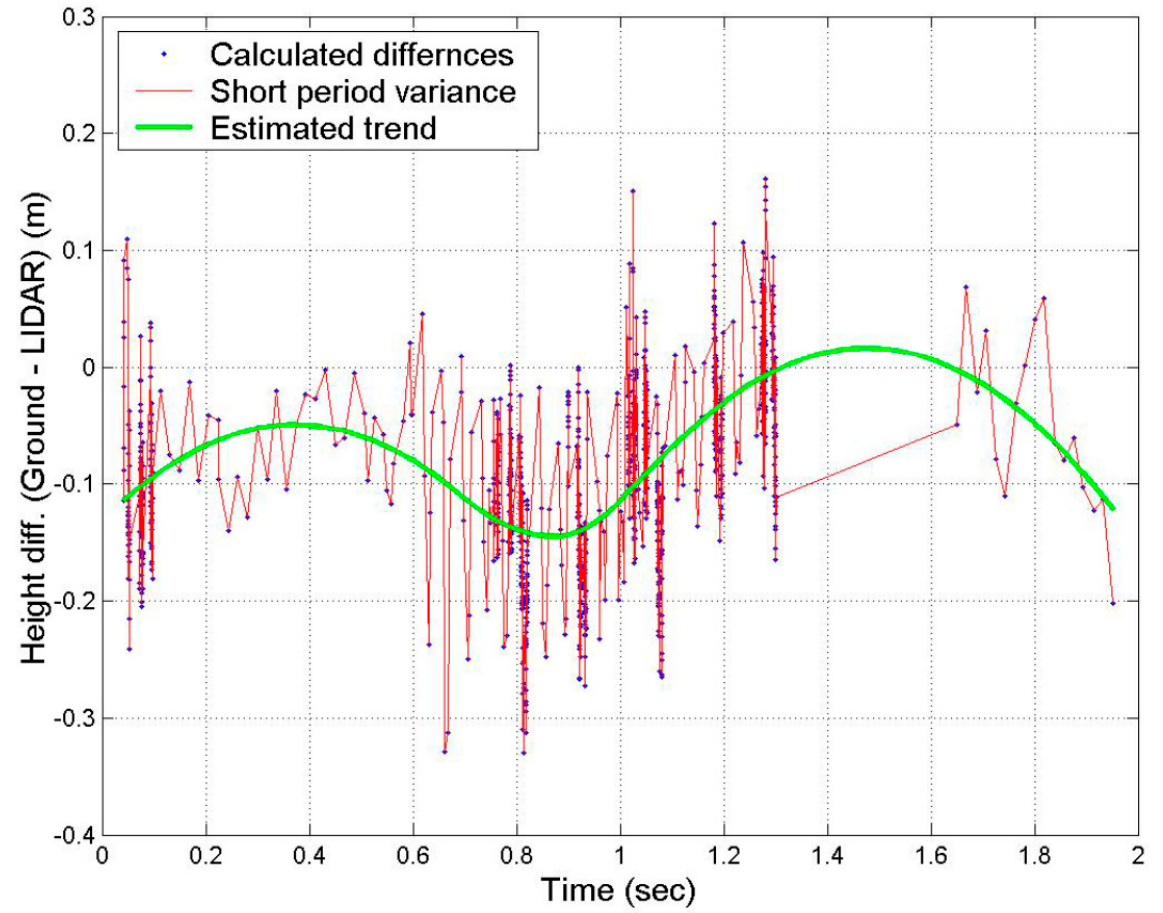
Figure 12. Height accuracy (Ground—LIDAR) with respect to time.